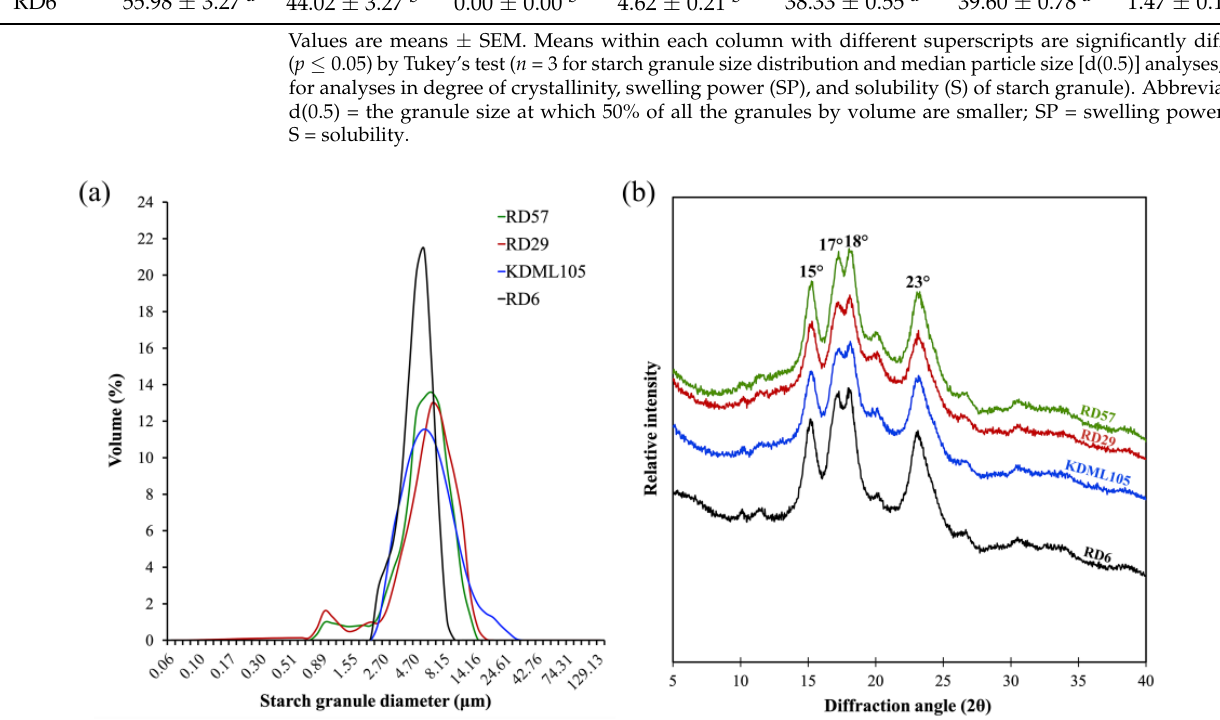
Figure 2. Structural characterization of starch from the caryopses of four Thai commercial rice cultivars differing in pasting properties. ( a ) Starch granule size distribution; ( b ) X-ray diffraction patterns of starch granules.